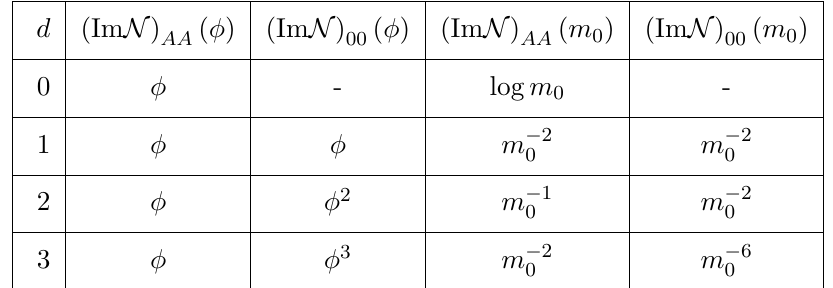
Table 3 . Table showing the leading behaviour of two key components of the gauge kinetic function. This is shown as a function of the one-parameter approach to the monodormy locus (cid:30) ! 1 , and as a function of the mass of the BPS states which become massless on the monodromy locus. In(cid:12)nite distance loci are classi(cid:12)ed by d > 0, while (cid:12)nite distance loci have d = 0. The subscript in (Im N ) runs over A = f 1 ; (cid:11) g for d = 3 but only over A = f (cid:11) g for d = 0 ; 1 ;